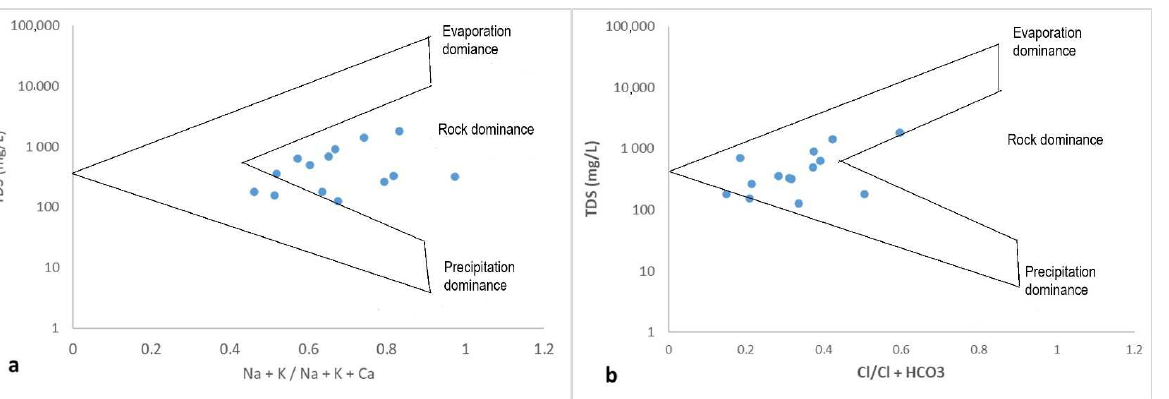
Figure 3. Piper diagram indicating the water types in the Soutpansberg region.